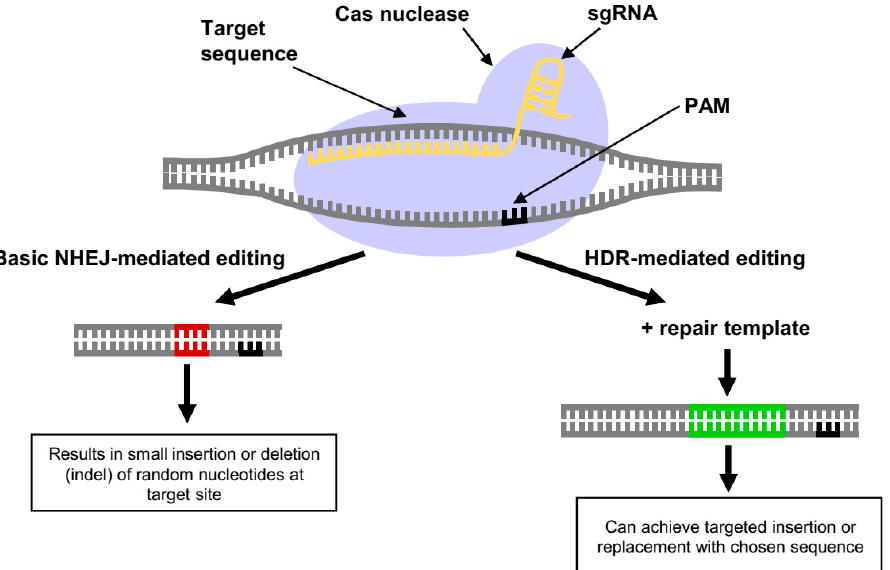
Figure 1. CRISPR/Cas-mediated gene editing platforms achieved through the targeted elicitation of double-stranded DNA breaks and NHEJ or HDR repair. HDR, homology-directed repair; NHEJ, non-homologous end joining; PAM, protospacer adjacent motif; sgRNA, single guide RNA.